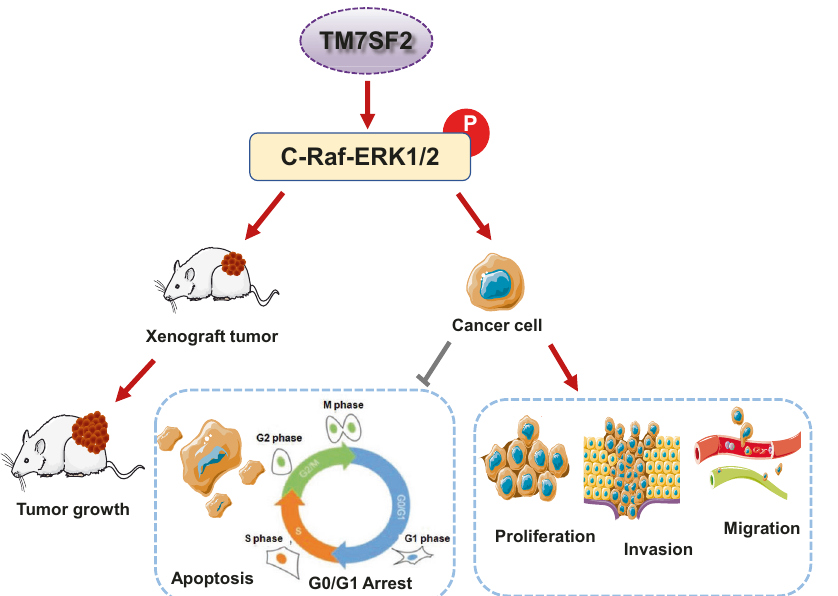
Fig. 8 A graphical diagram illustrates how TM7SF2 promotes the tumorigenesis of cervical cancer. TM7SF2 involves in promotion of cell proliferation, migration, invasion, tumor growth as well as inhibition of cell apoptosis and cell cycle progression. TM7SF2 triggers cervical tumorigenesis via the activation of the C-Raf-ERK pathway, and then promotes cell growth and inhibits apoptosis in cervical